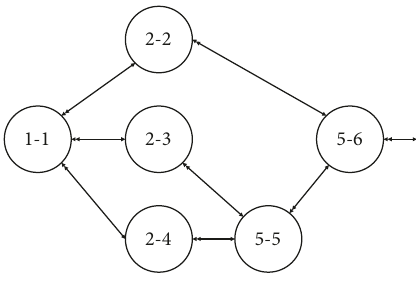
Figure 11: System model with a common